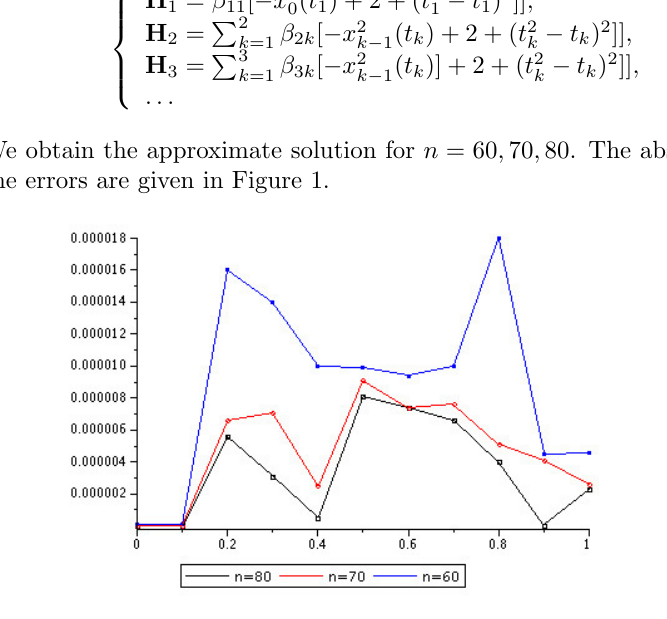
Figure 1. Absolute errors for n = 60 , 70 , 80 of Example